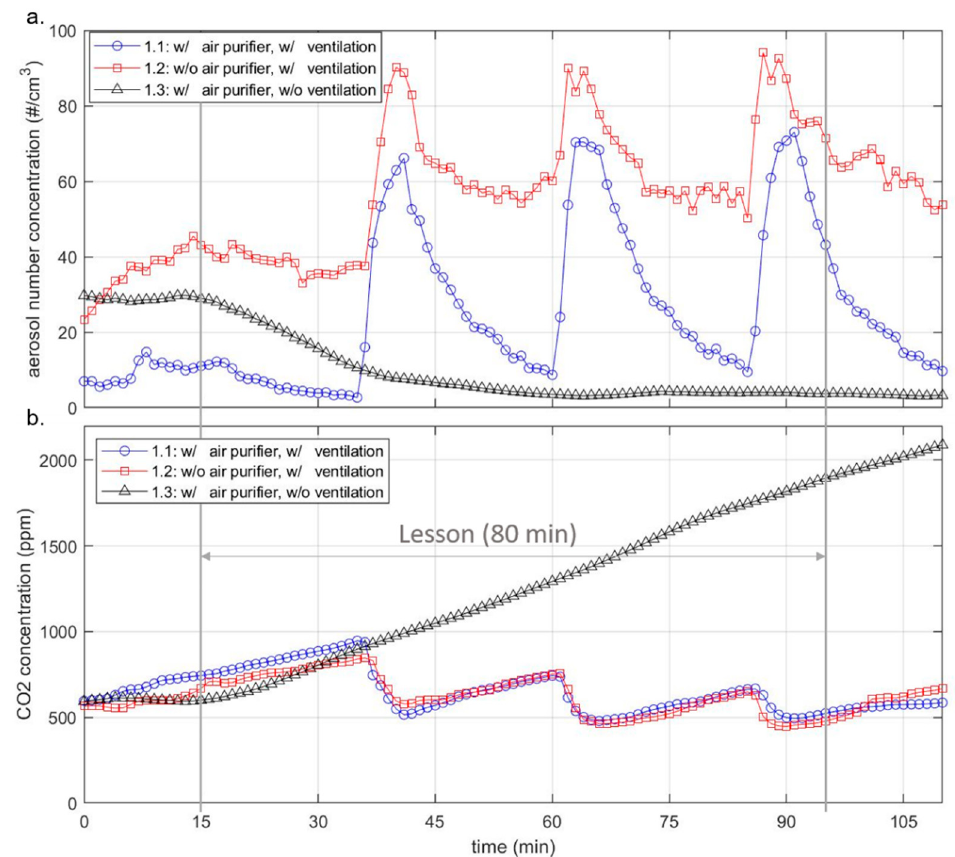
Figure 4. Aerosol number concentration ( a ) and CO 2 ( b ) concentration for three different scenarios. The first scenario (blue) includes an AP at an air exchange rate of 5.4 h − 1 and with manual ventilation every 20 min for 5 min. The second scenario (red) keeps the ventilation but with AP switched